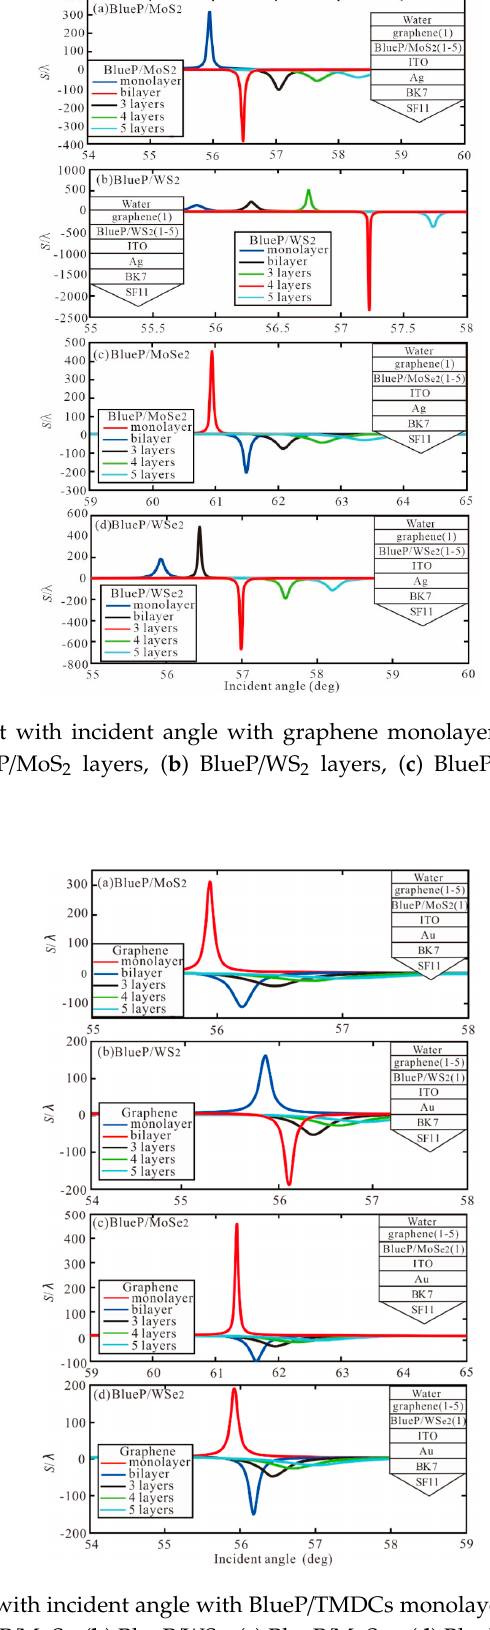
Figure 6. The GH shift with incident angle with BlueP/TMDCs monolayer and different number of graphene layers ( a ) BlueP/MoS 2, ( b ) BlueP/WS 2 , ( c ) BlueP/MoSe 2 , ( d ) BlueP/WSe 2 . In Table 5, the optimal GH shift with a different number of BlueP/TMDCs and graphene layers are summarized, where the bold indicates the highest GH shift value under the structure. In the BlueP/MoS 2 and graphene, the highest GH shift is − 385.8 λ in BlueP/MoS 2 bilayer and graphene monolayer. Then, the maximum GH shift with BlueP/WS 2 four layers and graphene monolayer is -2361 λ . Subsequently, the largest GH shift with BlueP/WSe 2 three layers and graphene monolayer of -655.5 λ is obtained. Finally, the highest GH shift of 456.9 λ is obtained for both BlueP/MoSe 2 and graphene monolayer. Therefore, in the Ag-ITO-BlueP/TMDCs–graphene structure, BlueP/WS 2 has the greatest contribution to GH shift. The monolayer of graphene has the best performance.